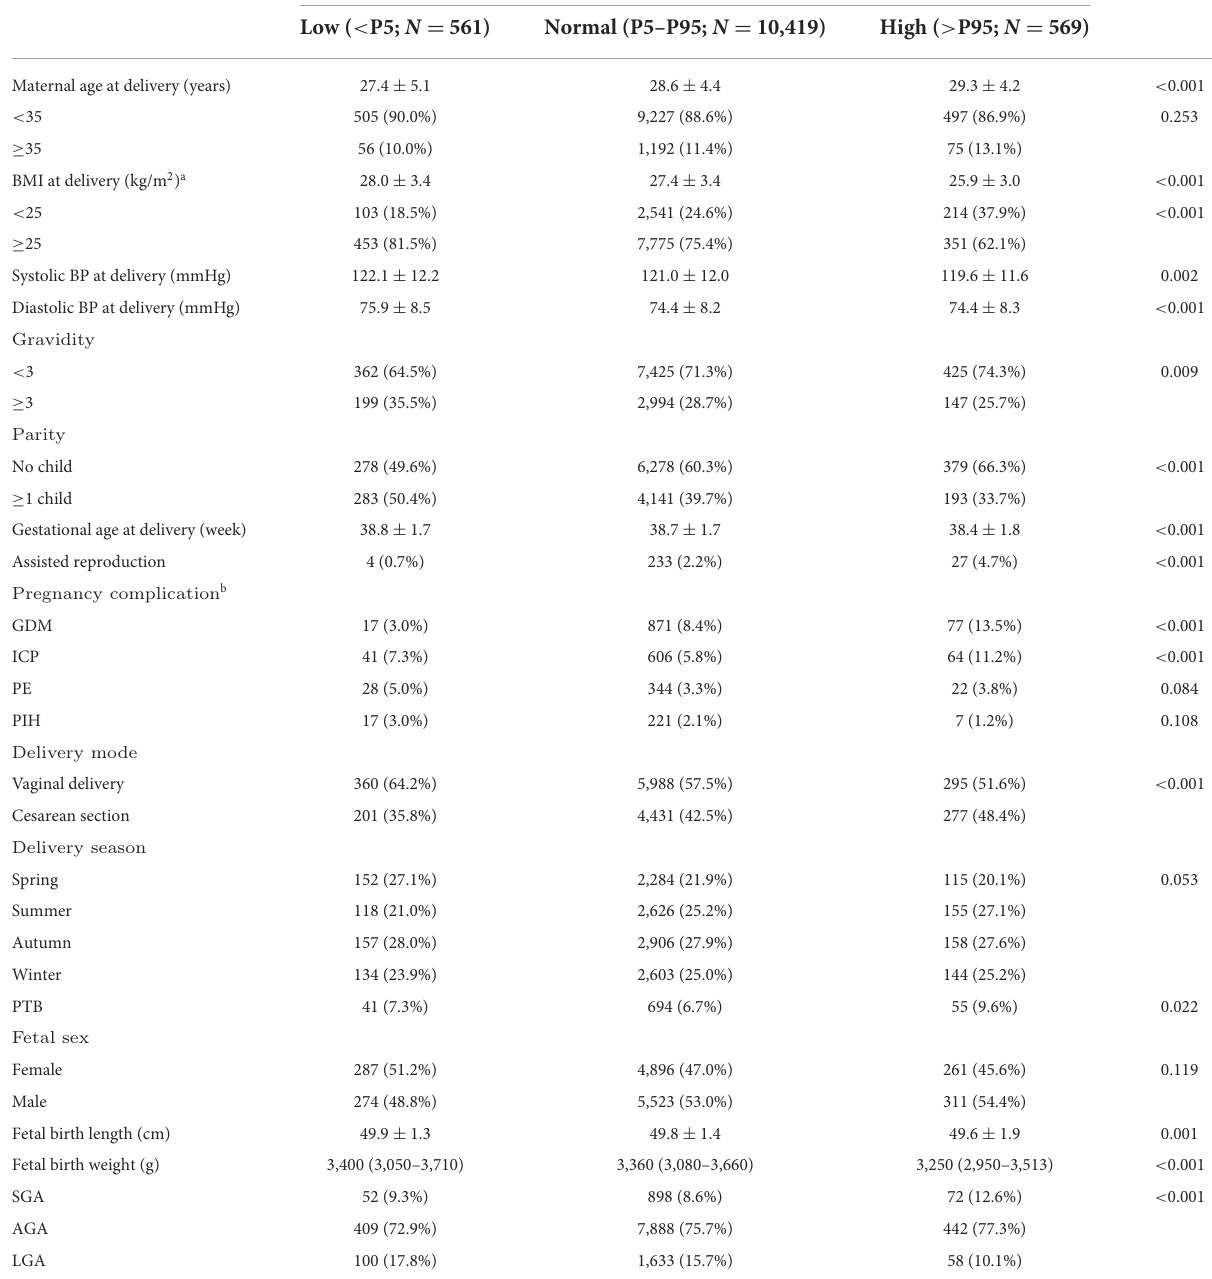
TABLE 2 Characteristics of study populations according to the categories of maternal serum vitamin B12 levels during late pregnancy. Vitamin B12